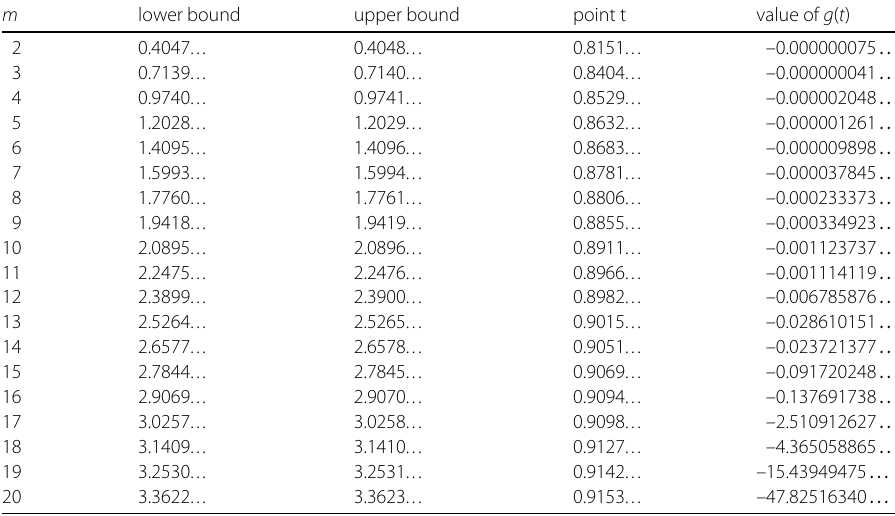
Table 1 Bounds for coefficients k (3, m ) for m = 2, ... ,20